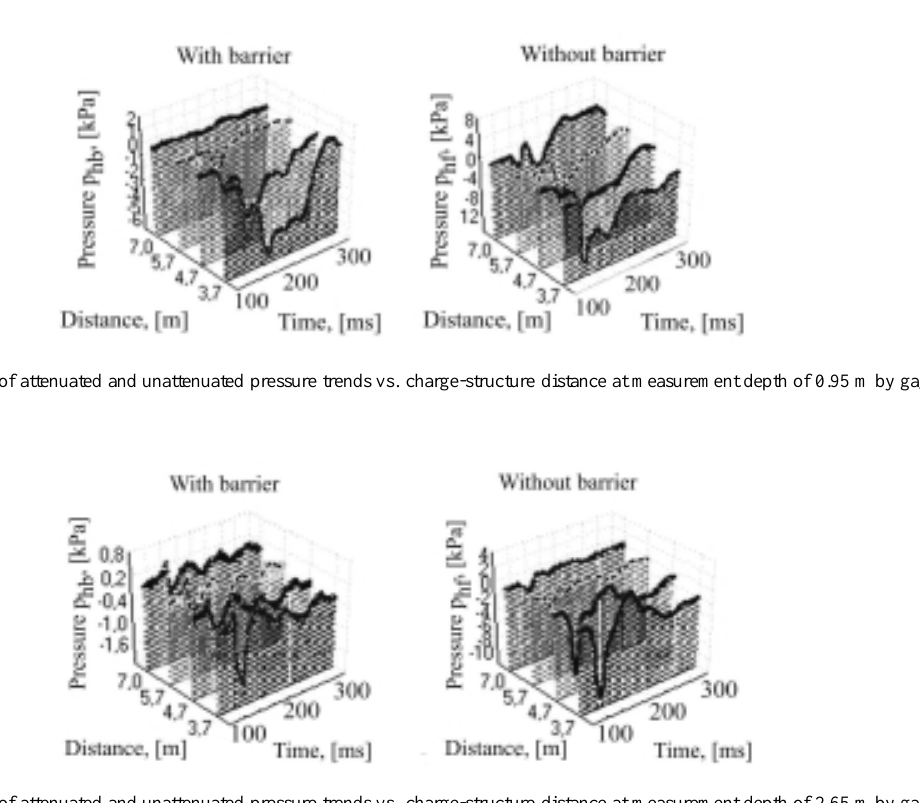
Fig. 23. Comparison of attenuated and unattenuated pressure trends vs. charge-structure distance at measurement depth of 2.65 m by gage no. 8 ( z/D = 1.01).